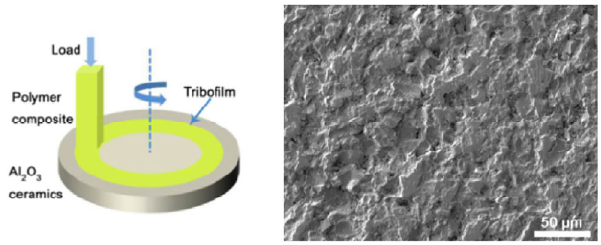
Fig. 4 Schematic illustration of POD tribological test and the surface morphology of Al 2 O 3